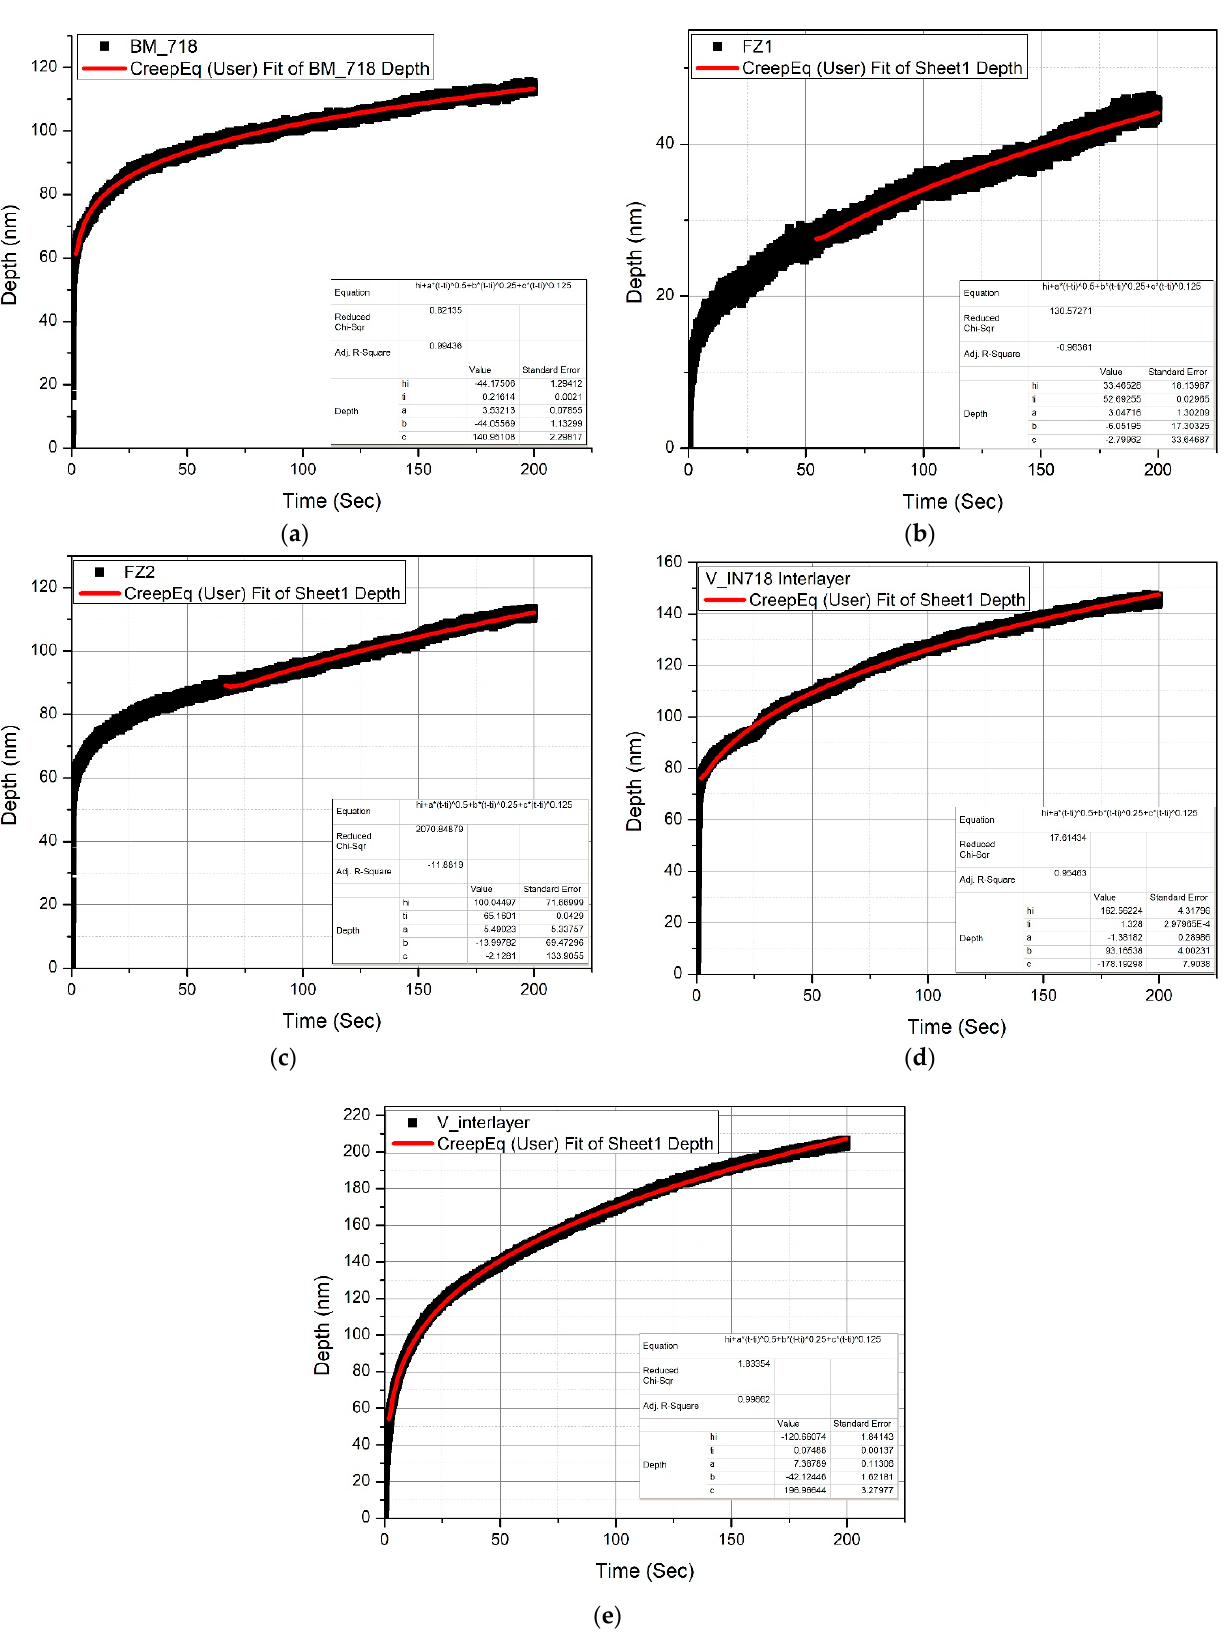
Figure 19. Experimental data and fitted depth–time curves for: ( a ) BM/IN718; ( b ) FZ1; ( c ) FZ2; ( d ) V/INC 718; and ( e ) the V interlayer.